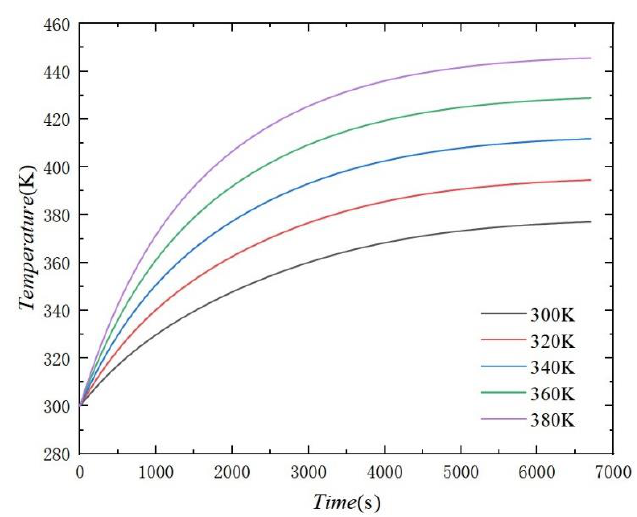
Figure 14. Temperature of accessory 2 with different fuel temperatures.